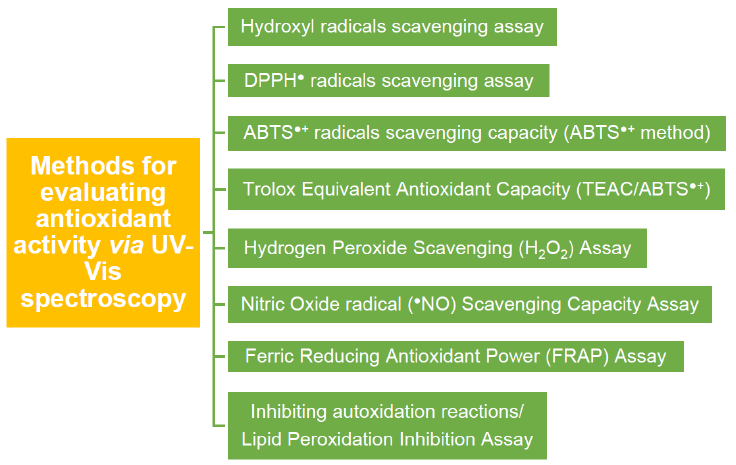
Figure 12. Multiple methodologies are referred to in the literature for evaluating antioxidant activity using UV – Vis